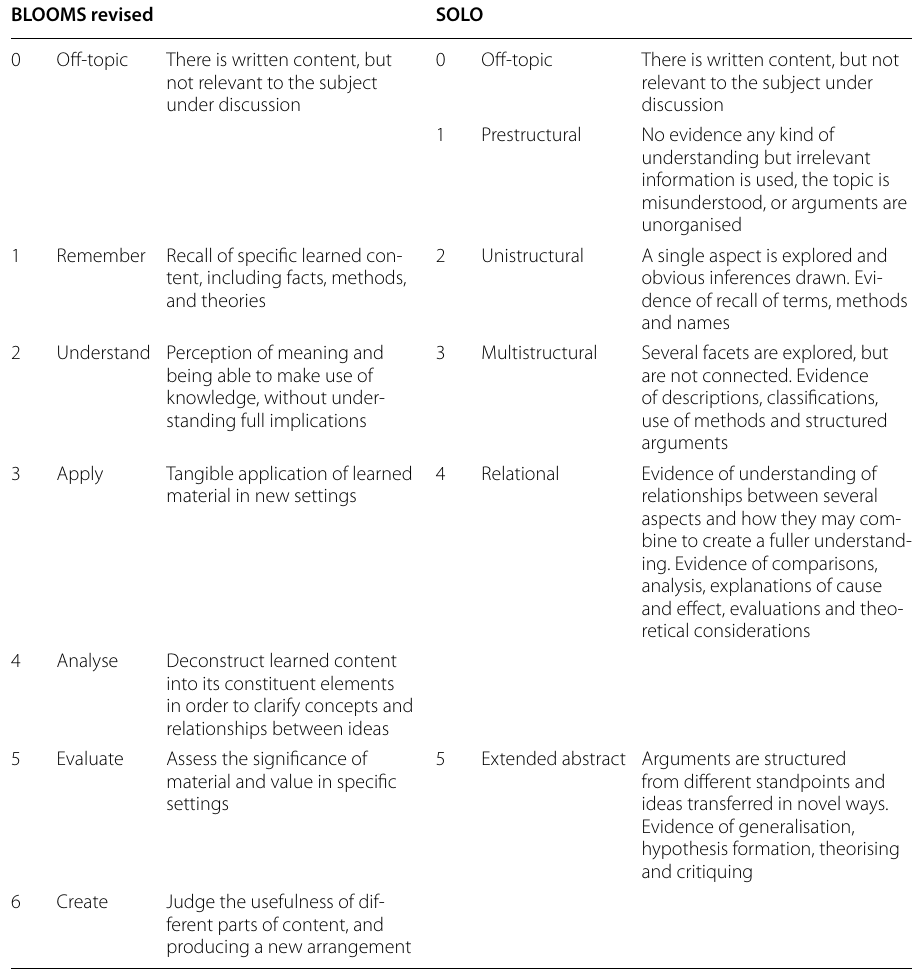
Table 7 Combined taxonomies with descriptors from O’Riordan et al. (2016) BLOOMS revised SOLO 0